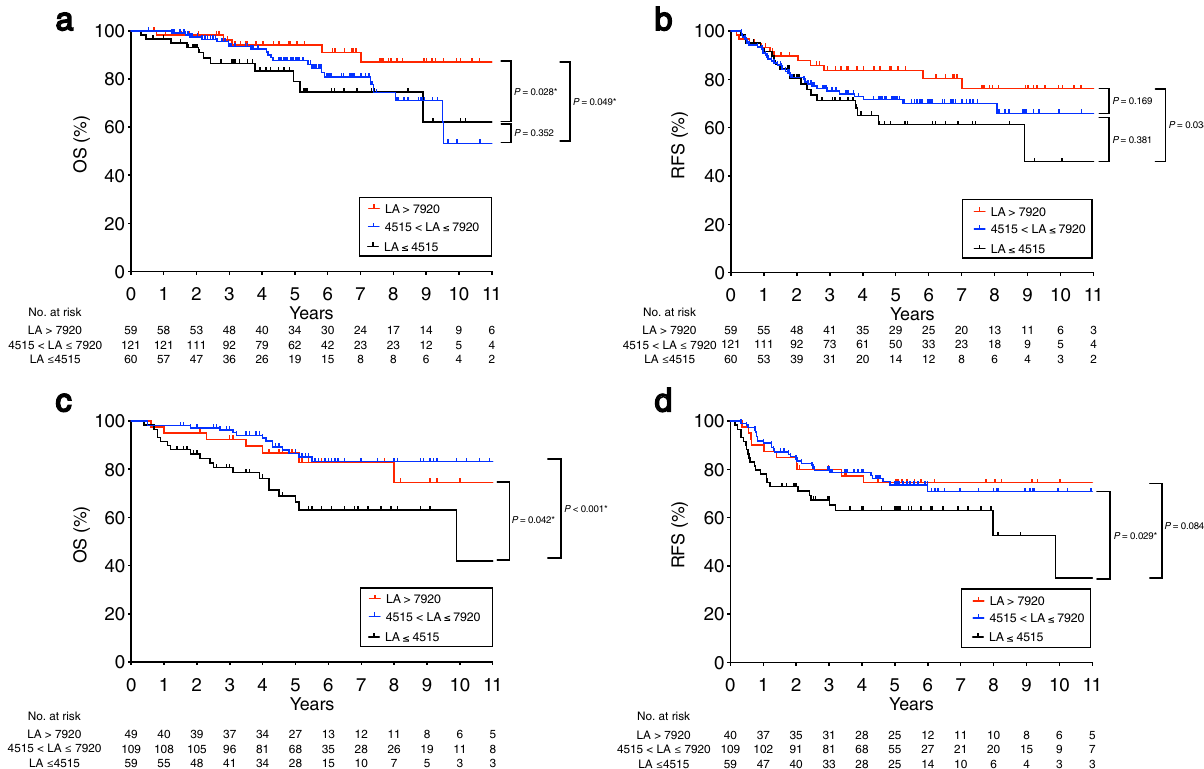
Figure 3. Stratification of the prognostic impact of LA levels in the discovery cohort ( a , b ) and validation cohort ( c , d ). Comparison of prognostic impact on OS ( a , c ) and RFS ( b , d ) among three groups; higher LA group (LA > 7920), middle LA group (4515 < LA ≤ 7920), and lower LA group (LA ≤ 4515). The upper quartile and the lower quartile of LA were 7920 and 4515, respectively. * P <